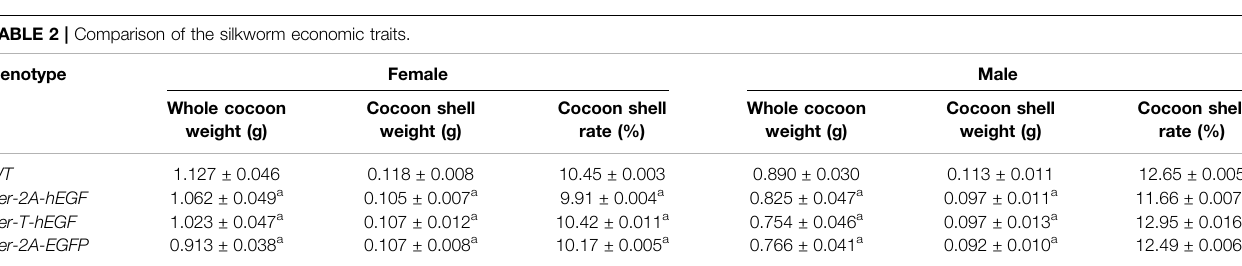
TABLE 2 | Comparison of the silkworm economic